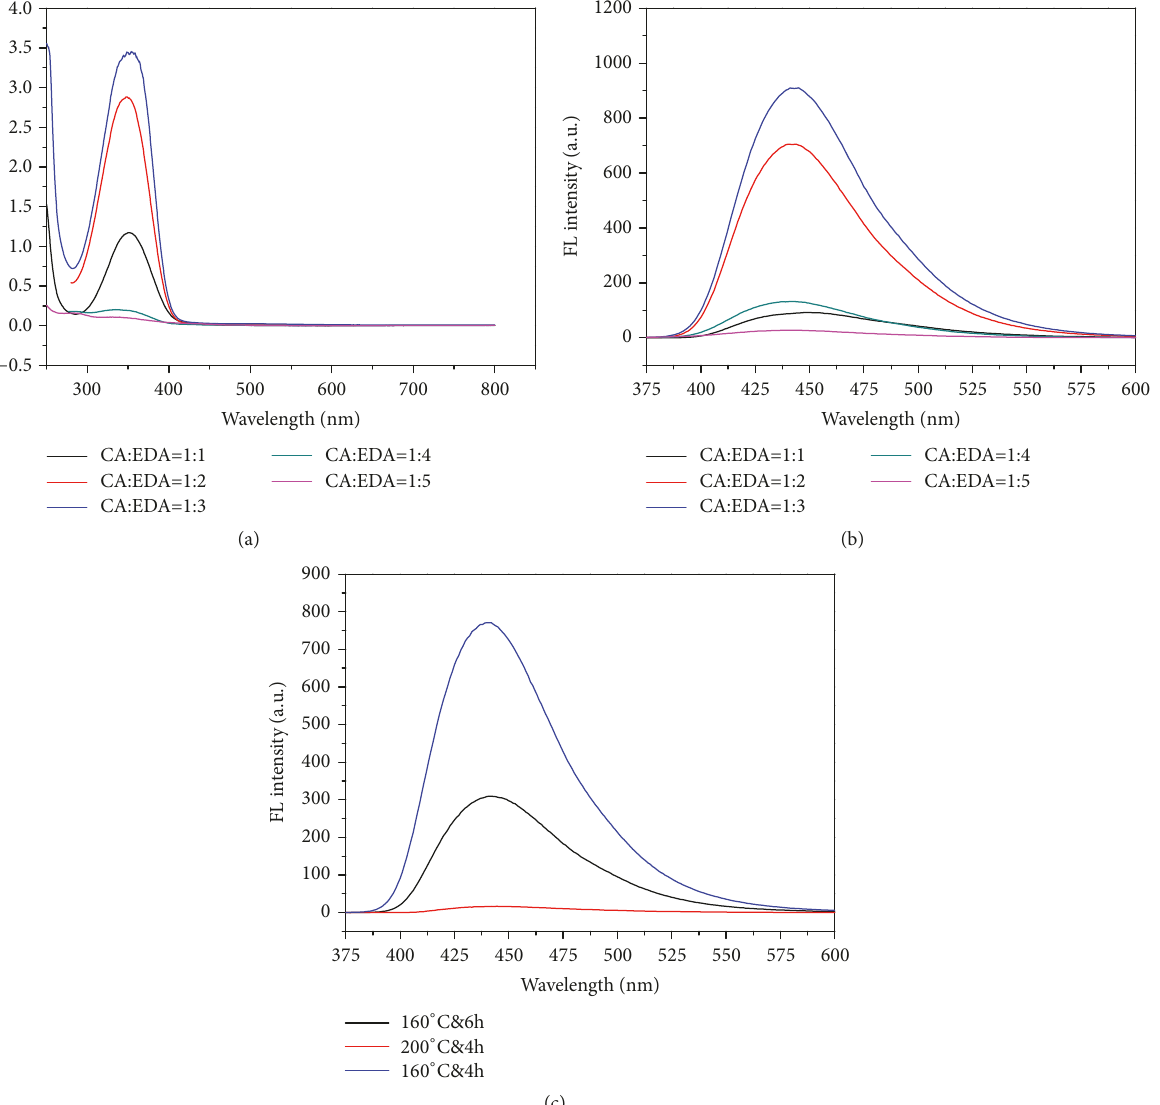
Figure 5: (a) UV-Vis absorption spectra of N-GQDs with different ethylenediamine content (the ratio of citric acid to ethylenediamine was 1:1, 1:2, 1:3, 1:4, and 1:5, respectively); (b) fluorescenceintensity spectra of N-GQDs with different ethylenediamine contentat 350nm excitation wavelength (the ratio of citric acid to ethylenediamine was 1:1, 1:2, 1:3, 1:4, and 1:5, respectively); (c) fluorescence intensity spectra at 350nm with different heating temperature and